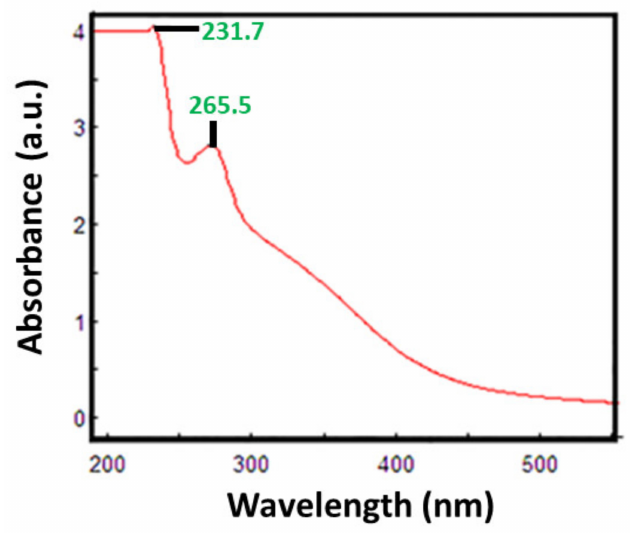
Figure 3. UV-Visible spectrum of aqueous SA-LE. Note: high peak and plateau in the spectrum could be due to the high concentration of the sample (un-diluted).